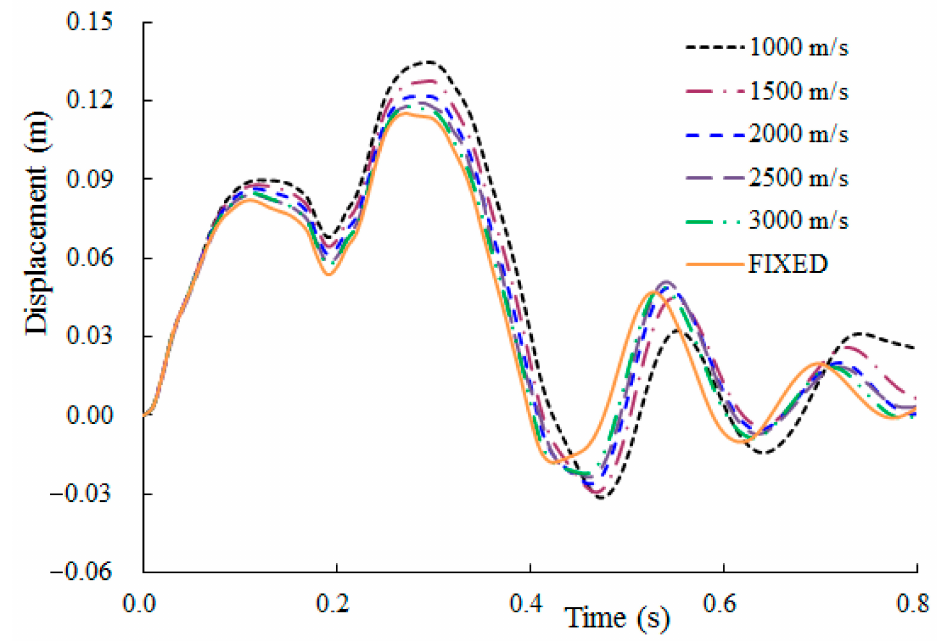
Figure 9. Max displacement time-histories of containment.